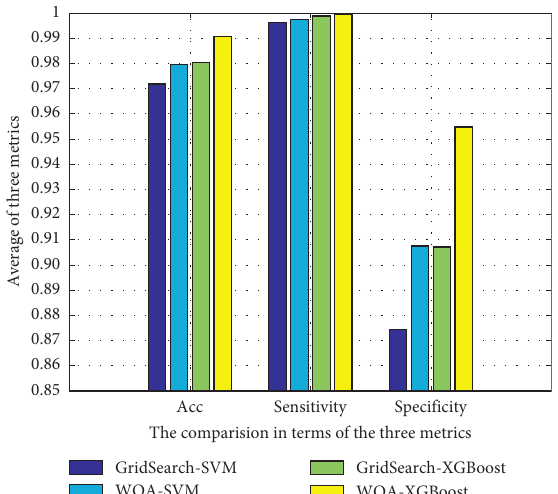
Figure 4: The comparison in terms of the three metrics and standard